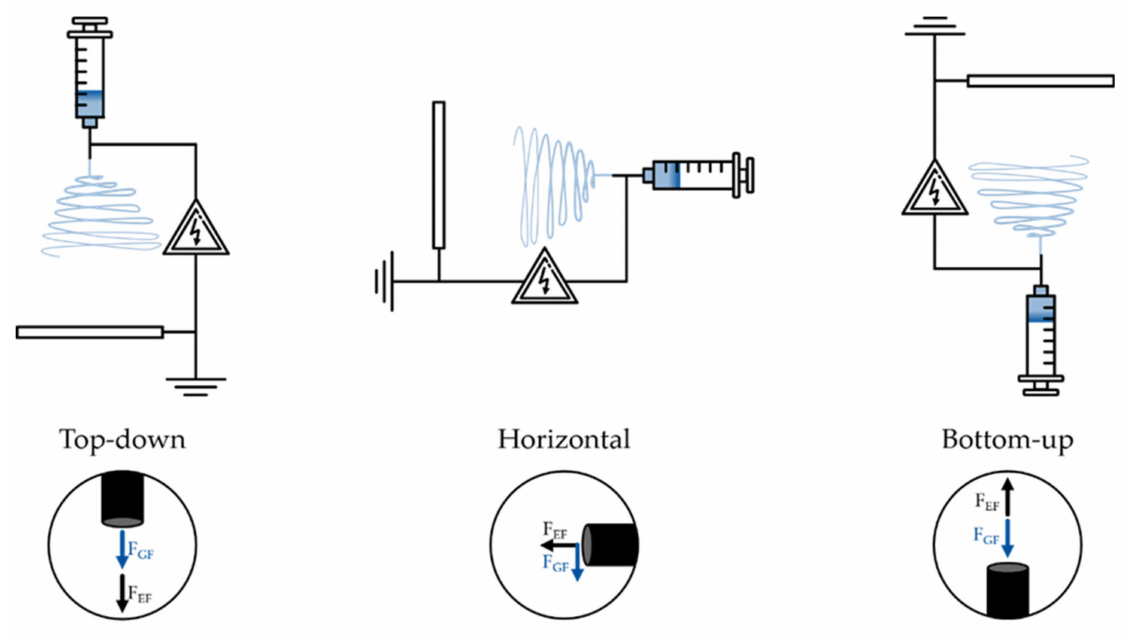
Figure 2. Schematic of the di ff erent electrospinning setups (GF—gravity, EF—electric